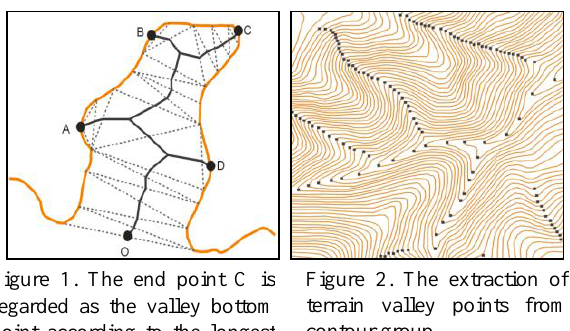
Figure 2. The extraction of terrain valley points from contour